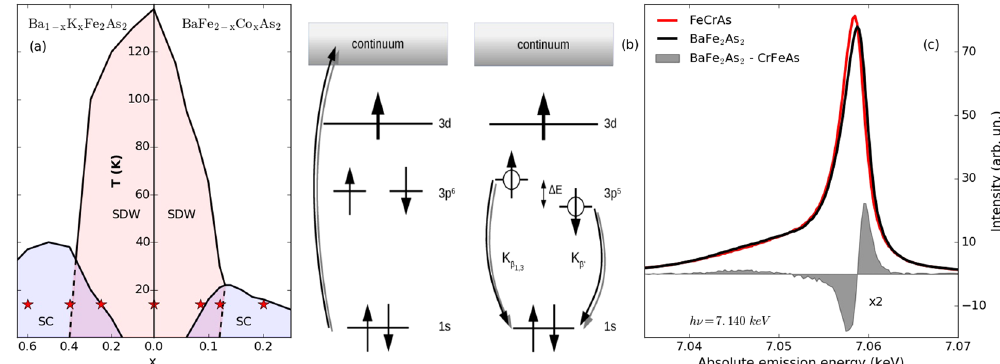
Figure 1. ( a ) Phase diagram of Ba 1 − x K x Fe 2 As 2 and Ba 1 − x K x Fe 2 As 2 . The red stars depict the doping levels measured. ( b ) Sketch of the XES process. ( c ) Exemplary Fe-K β XES for FeCrAs and BaFe 2 As 2 at 15 K. The former is taken as a reference and the difference spectrum is obtained (see main text) and depicted as gray shadowed